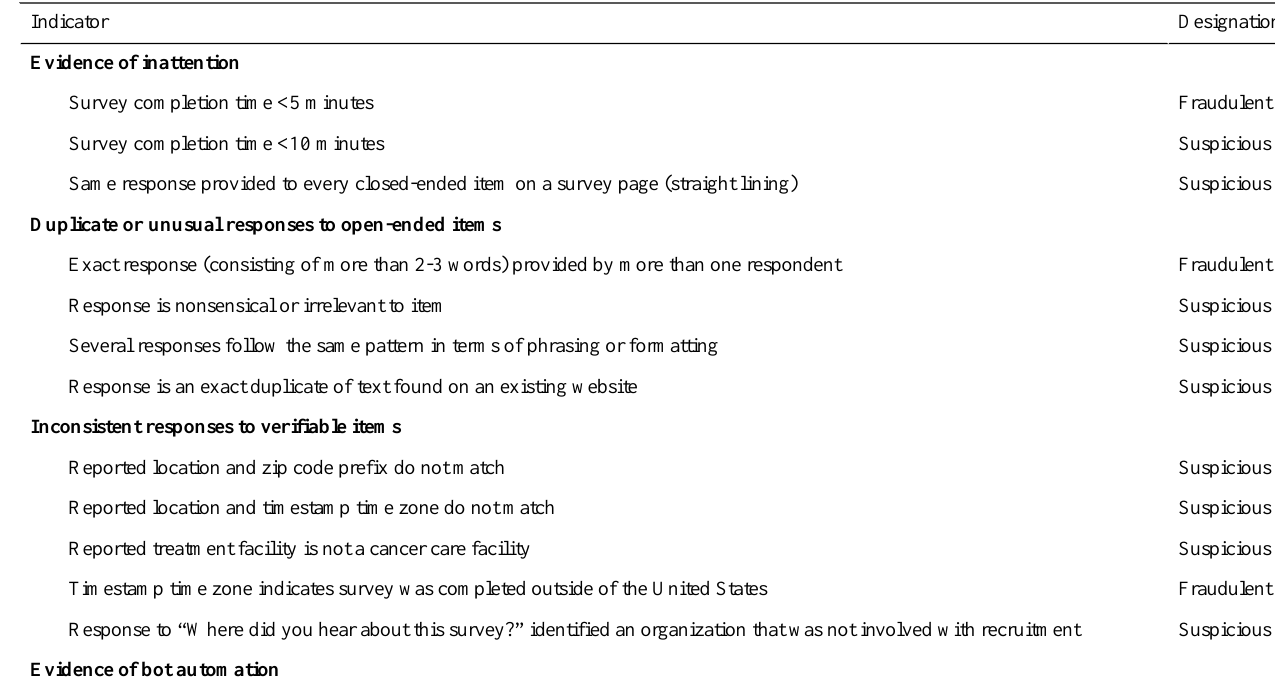
Table 1. Indicators of low-quality or fraudulent